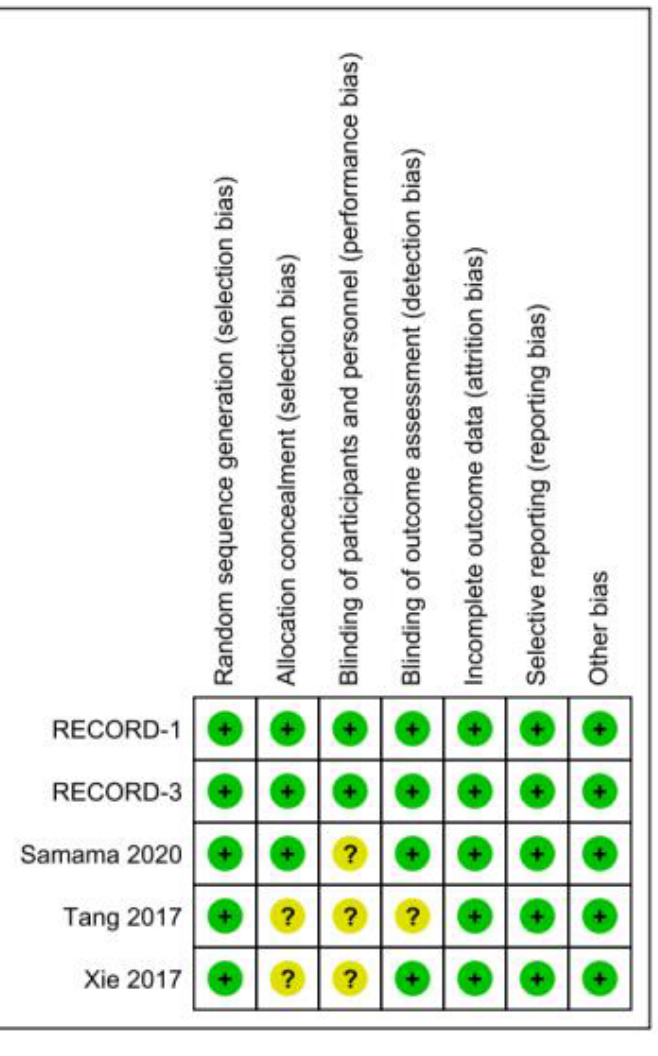
Figure 1. Risk of bias assessment results.